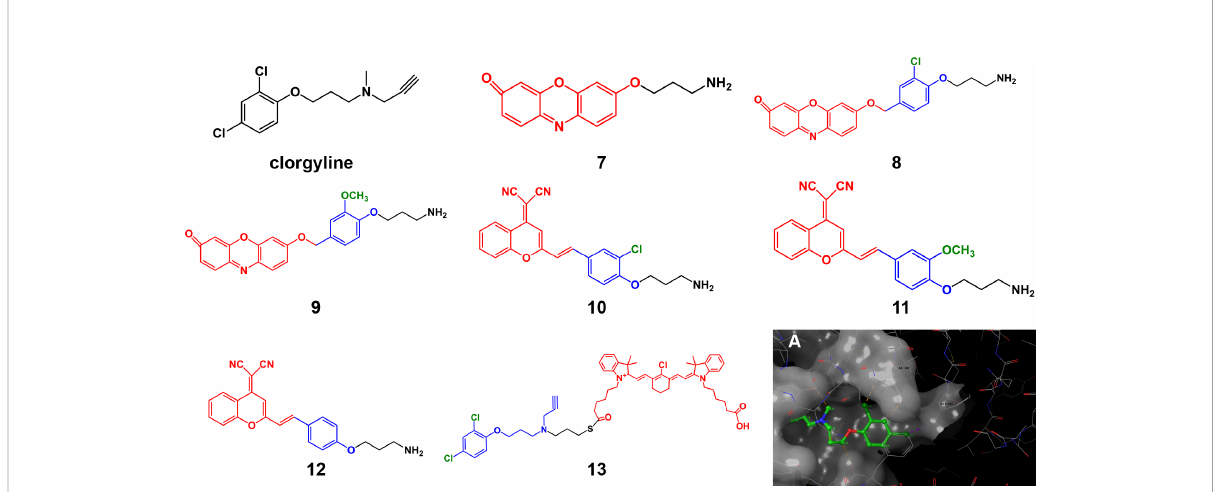
FIGURE 3 Structures of clorgyline and clorgyline-derived AfPIs (Blue, inhibitor structure; red fl uorophores). (A) Molecular docking shows that clorgyline forms hydrogen bonds between its chlorine atoms and the Cys323 and Thr326 residues of MAO-A (PDB ID: